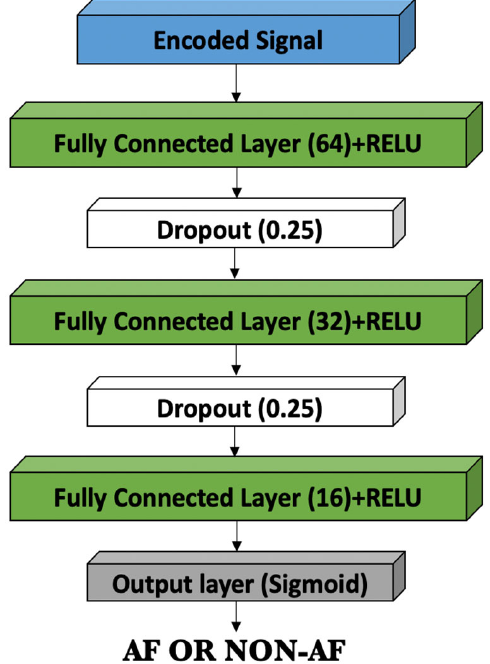
Figure 3. The classification module of the MsRes. Table 3. The proposed detailed structure of the system describes the input of each layer with the number of